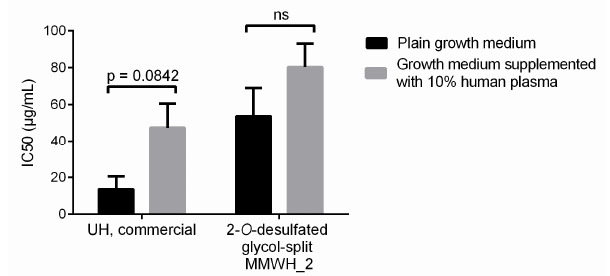
Figure 8. IC50 of the two samples from Figure 7 in P. falciparum in vitro cultures grown in either plain growth medium or in growth medium supplemented with 10% human plasma. ns: not significant.